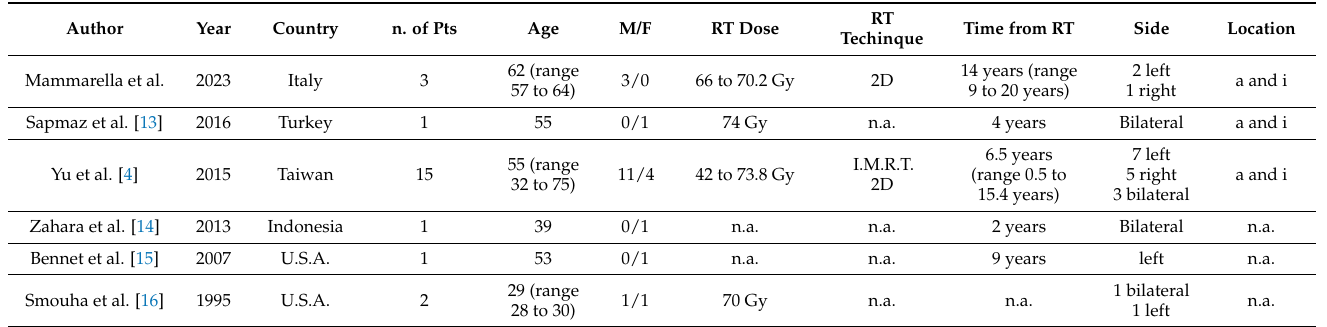
Table 1. Main features of the studies included in the present systematic